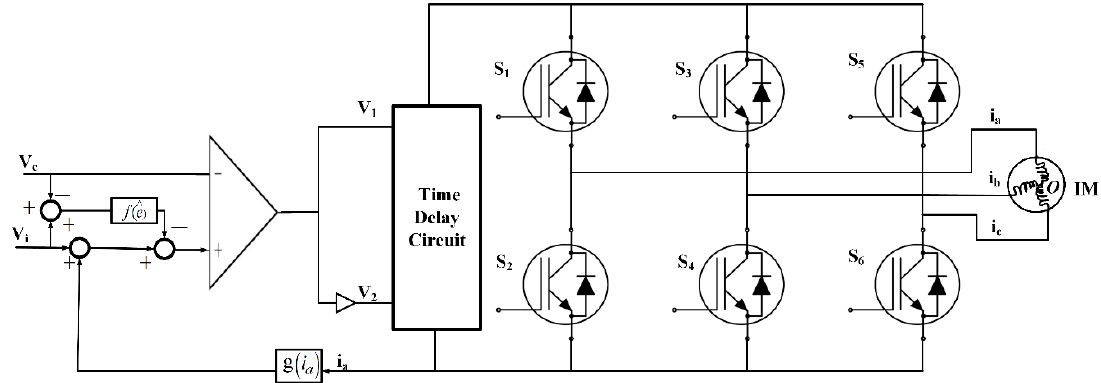
Figure 8. Three-phase SPWM inverter with the proposed DTC method.